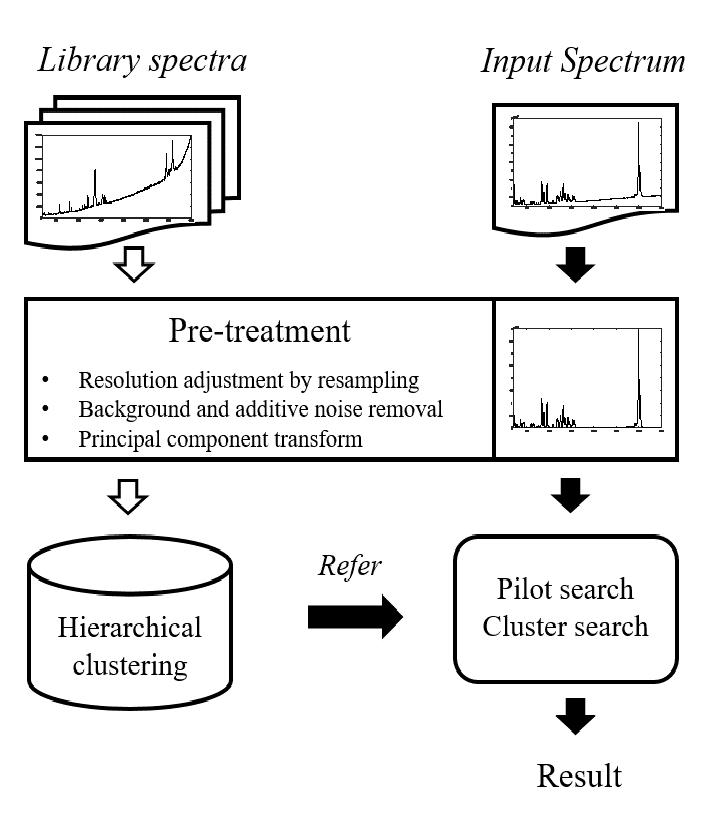
Figure 4. Flowchart of proposed